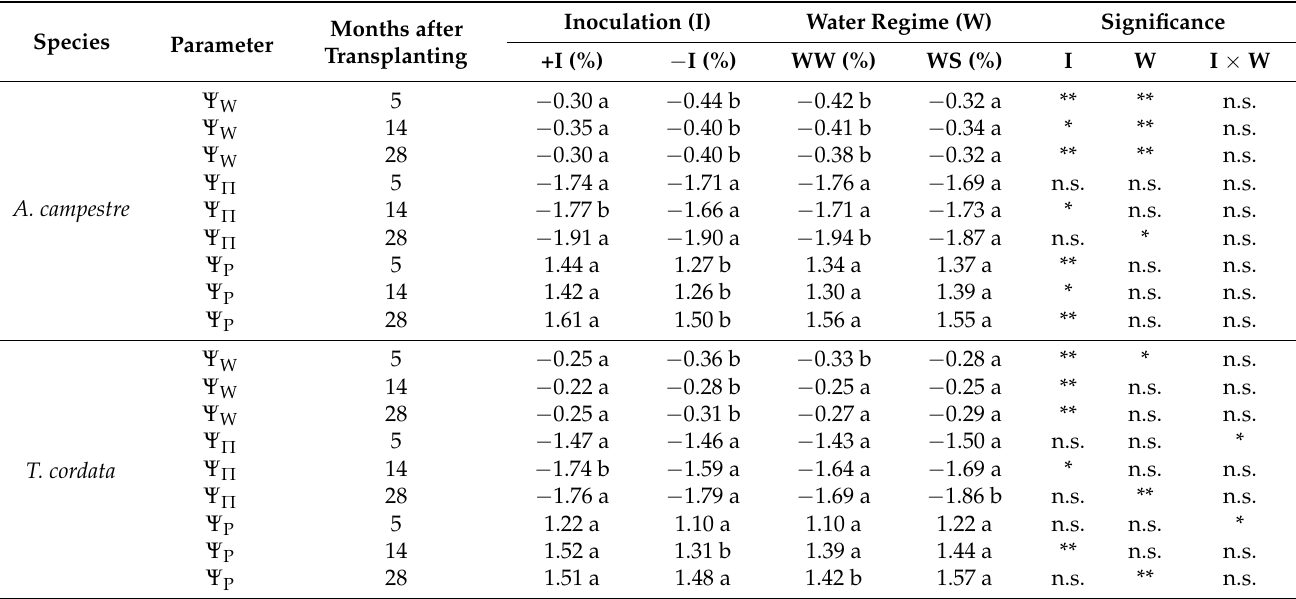
Table 4. Effect of mycorrhizal inoculation and water regime in the nursery on leaf pre-dawn water potential ( Ψ w , MPa), leaf osmotic potential ( Ψ Π , MPa) and leaf turgor potential ( Ψ P , MPa) of Acer campestre L. and Tilia cordata Mill. measured 5, 14 and 28 months after